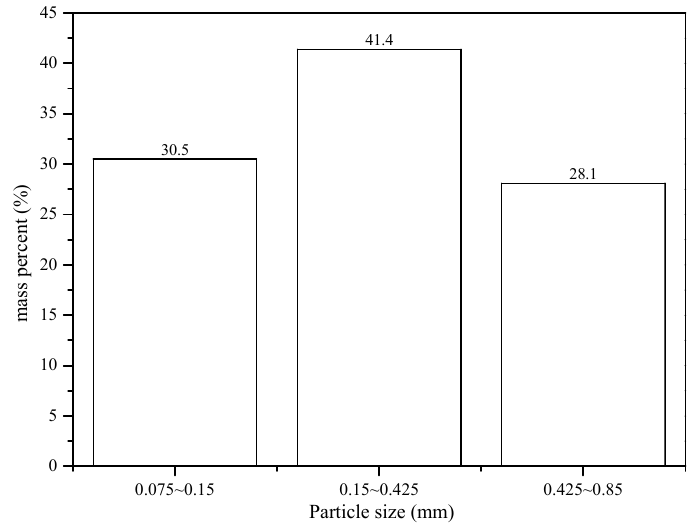
Figure 2. Size of distributions of antimony ore processing wastes.